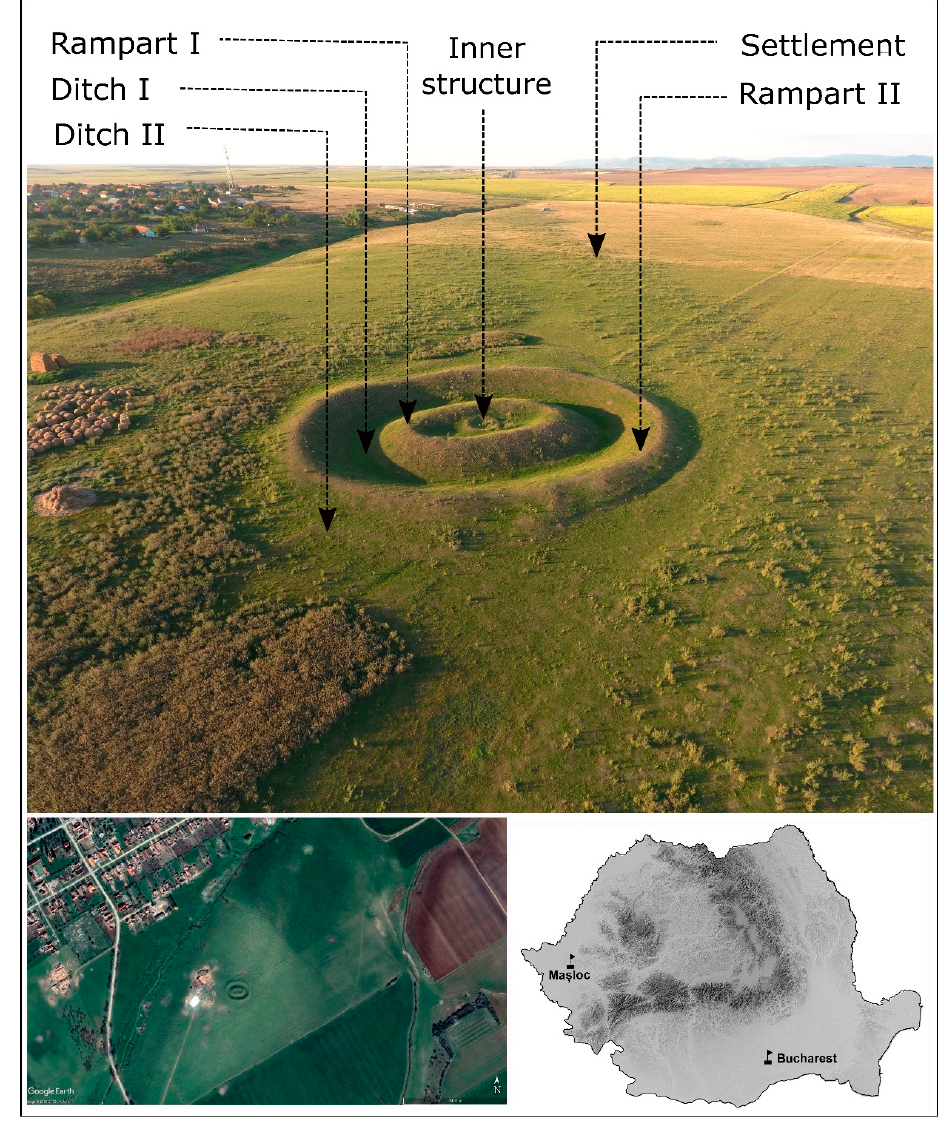
Figure 2. The medieval site of Ma ș loc “ Ș an ț ul Turcilor” (drone photography (top), Google Earth image (30.03.2017) of the surroundings (bottom left) and localization (bottom right)).